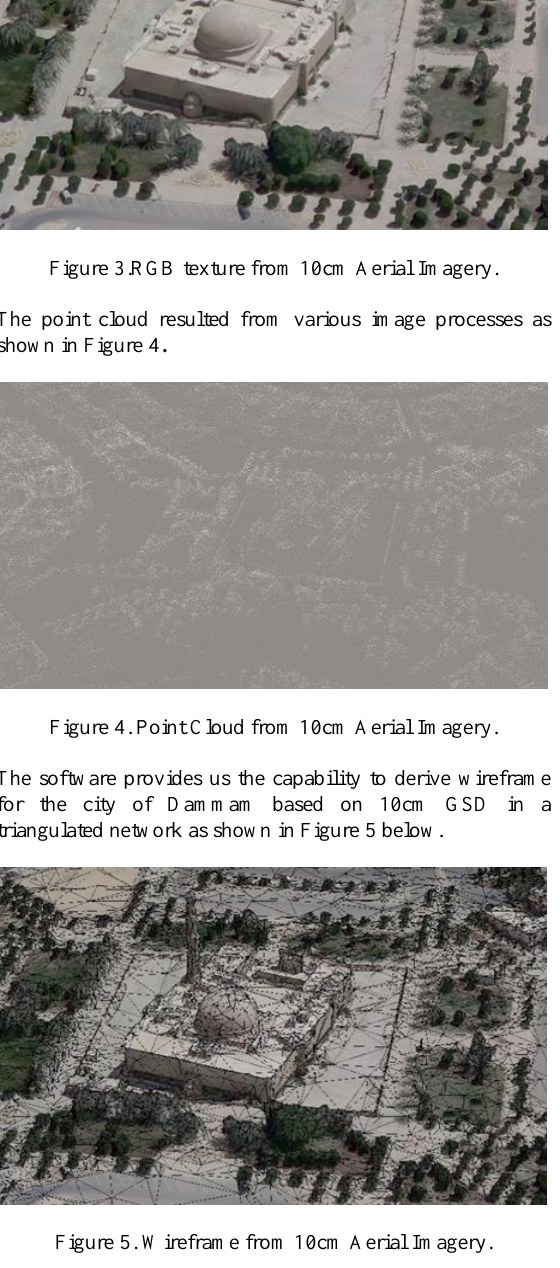
Figure 6. Stereo from 10cm Aerial